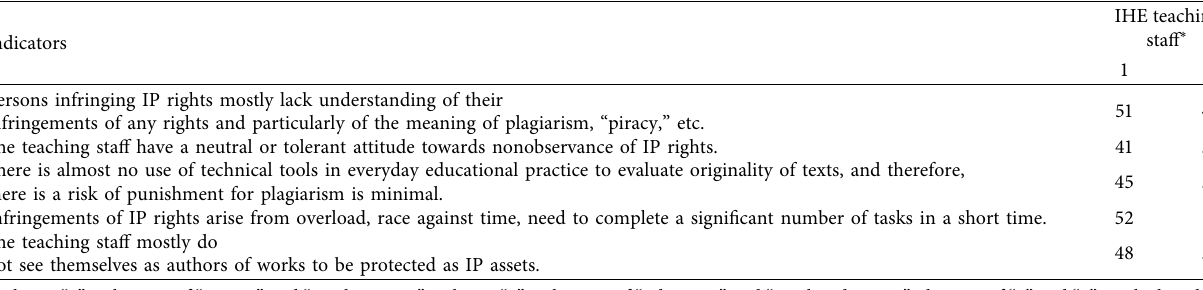
Table 6: Attitudes to the problem of IP rights infringements.